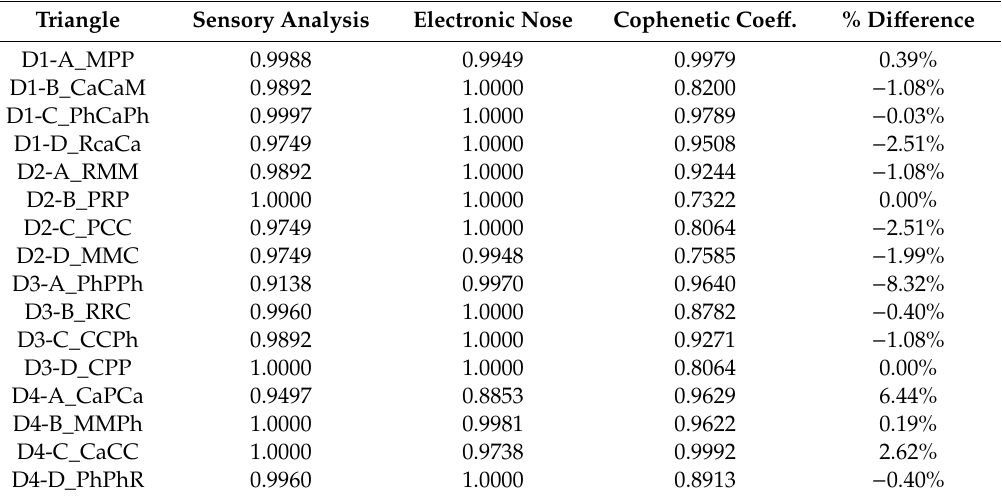
Table 8. Comparative results of sensory analysis and electronic nose analysis. Negative values in the “% Di ff erence” column indicate a better response from the electronic nose. Cophenetic correlation coe ffi cient values.